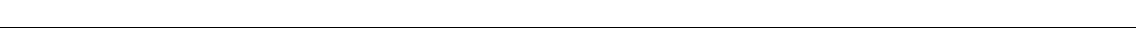
Fig. 1 Phosphorylation of Tau in PGRN-KI mice. a Immunohistochemistry with anti-phospho-TDP43 antibody revealed nuclear rod-like aggregates in NeuN- positive neurons of the frontal cortex (M2) of PGRN-KI mice at 24 weeks of age, but no such aggregates were observed in C57Bl/6J mice (left panels). Anti-TDP43 antibody with DAB (middle panel) revealed cytoplasmic stains (white arrow) and heterogeneous nuclear staining (black arrow). Anti-TDP43 antibody revealed nuclear and cytoplasmic staining, indicated by arrows (right panels). b Western blots for pTDP43 (pS409/410) of the sarkosyl-insoluble fraction of whole cerebral cortex from B6 and PGRN-KI mice at 24 weeks of age. Insoluble fractions contained full-length (FL) and C-terminal fragment (CTF) of phosphorylated TDP43. c Ubiquitin staining revealed cytoplasmic aggregates at 24 weeks (white arrow), and the abundance of nuclear aggregates increased at 48 weeks of age (black arrow). Representative images were taken from M2. d Summary of TDP43 and ubiquitin staining in various regions at the indicated time points. ‘ + ’ , 1 – 4 positive cells/ fi eld; ‘ ++ ’ , 5 or more positive cells/ fi eld ( fi eld size: 430 × 550 μ m). e Three types of anti-phospho-tau antibodies yielded different stain patterns in frontal associated cortex (FrA) of PGRN-KI mice. Anti-phospho-Ser203-tau antibody stained neuropils of PGRN-KI mice from 4 weeks of age, whereas anti-phospho-Thr220-tau antibody stained cytoplasm and neurites of PGRN-KI mice from 12 weeks of age. Anti-phospho-Ser191/Thr194-tau (AT8) antibody stained cytoplasm of cortical neurons only at 48 weeks. The similar chronological changes were observed in M2 and RSD. Antibody absorption was performed using each phosphorylated tau peptide. f Western blots with anti-phospho-Ser203-tau, anti- phospho-Thr220-tau, and anti-phospho-Ser191/Thr194-tau (AT8) antibodies. g Quantitative analyses of western blots with four mice at each time point. * p < 0.05; ** p < 0.01 ( N = 4, Student ’ s t -test). Averages and s.e.m. are shown. p -values are shown in Supplementary Data